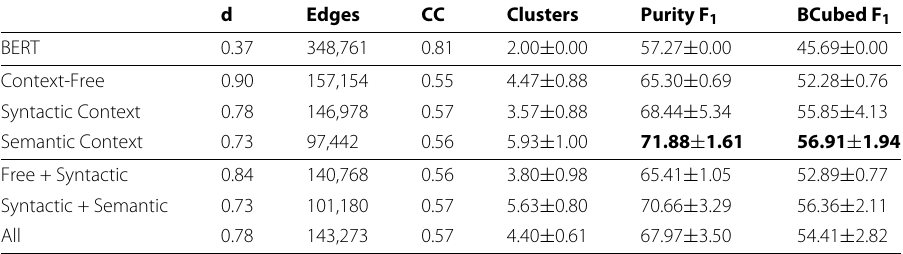
Table 5 Semantic role induction results achieved using different contextualized representations of verb